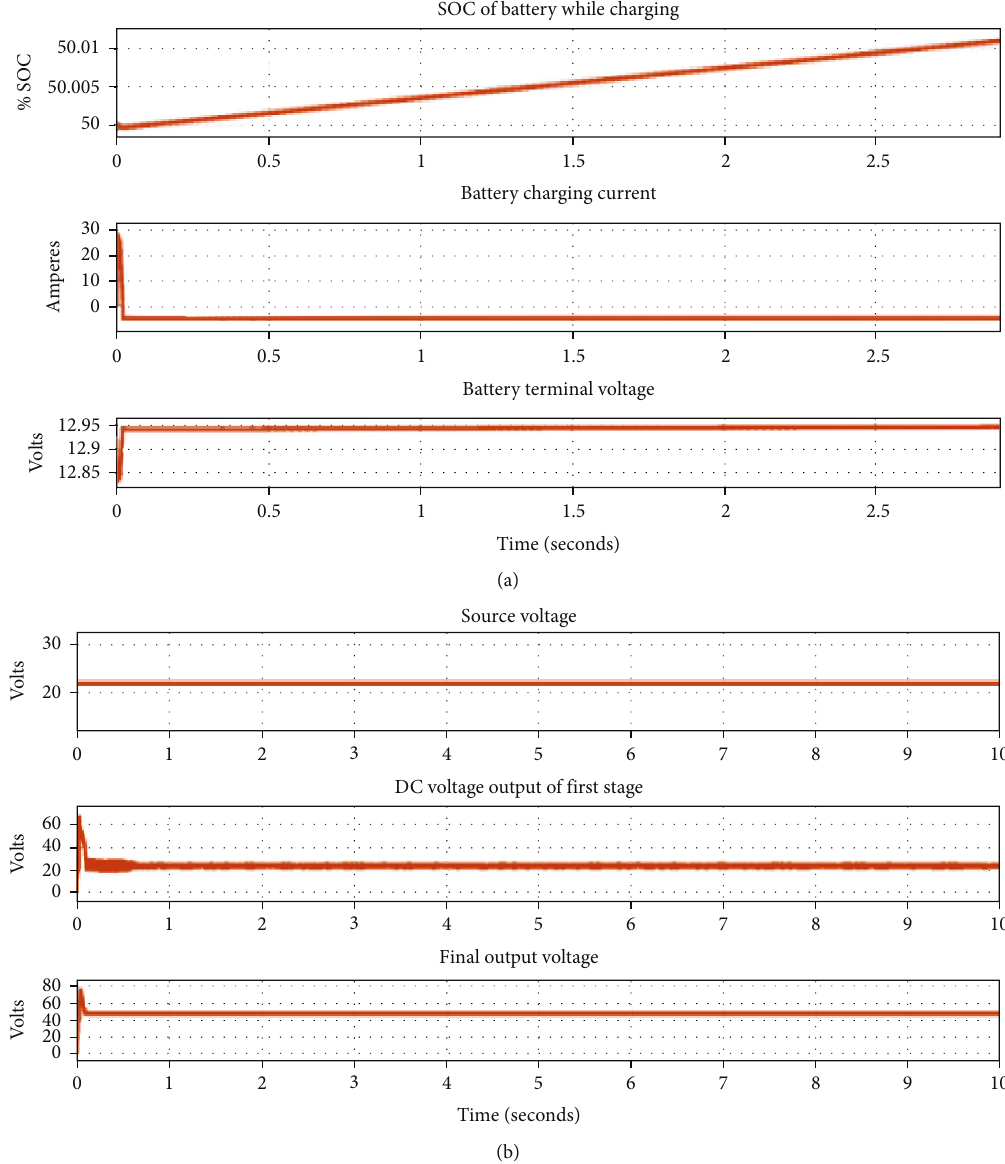
Figure 14: (a) SOC of battery I